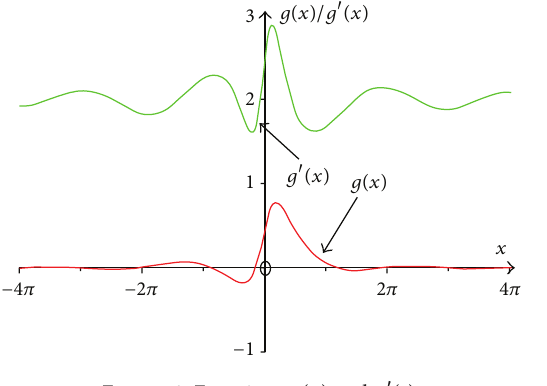
Figure 3: Functions 𝑔(𝑥) and 𝑔 󸀠 (𝑡) .